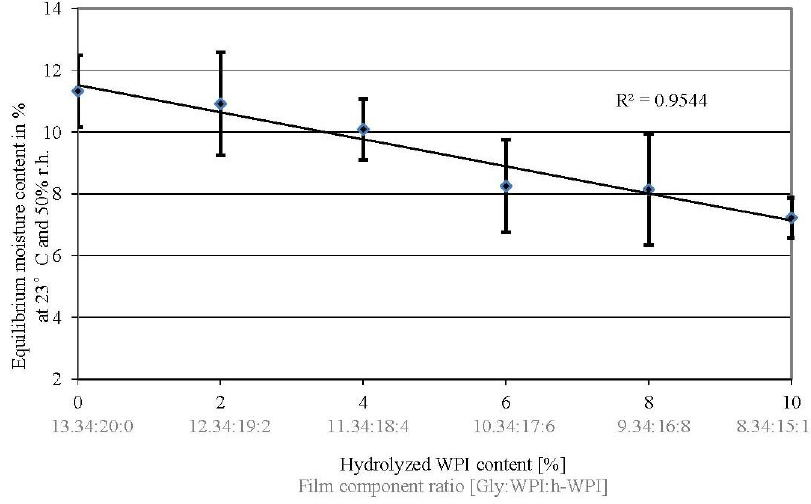
Figure 1. Effect of increased h-WPI content (reduced protein molecular weight (M reduced glycerol contents on the equilibrium moisture content of WPI-based films at 23 °C and 50%